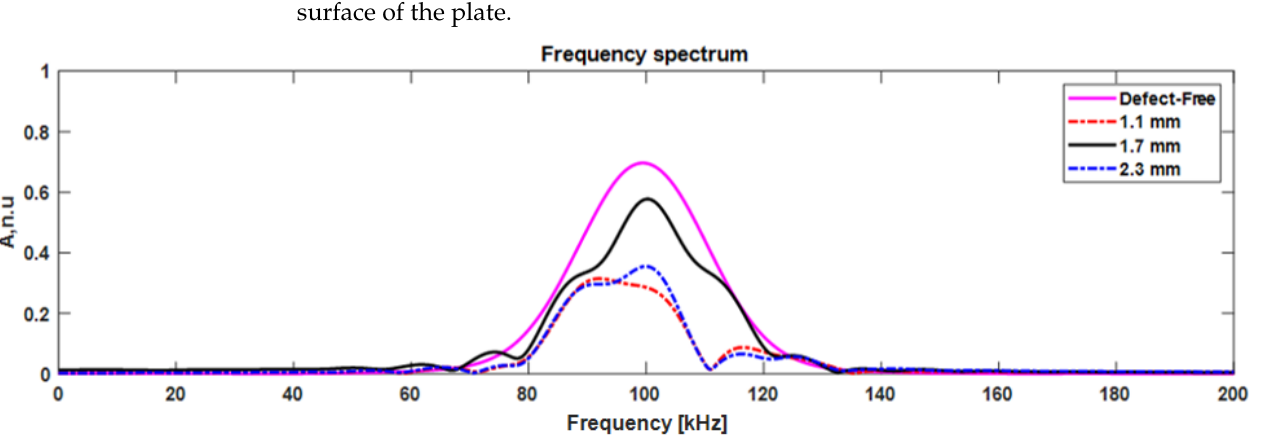
Figure 15. The frequency spectrum of transmitted A (cid:2868) mode.